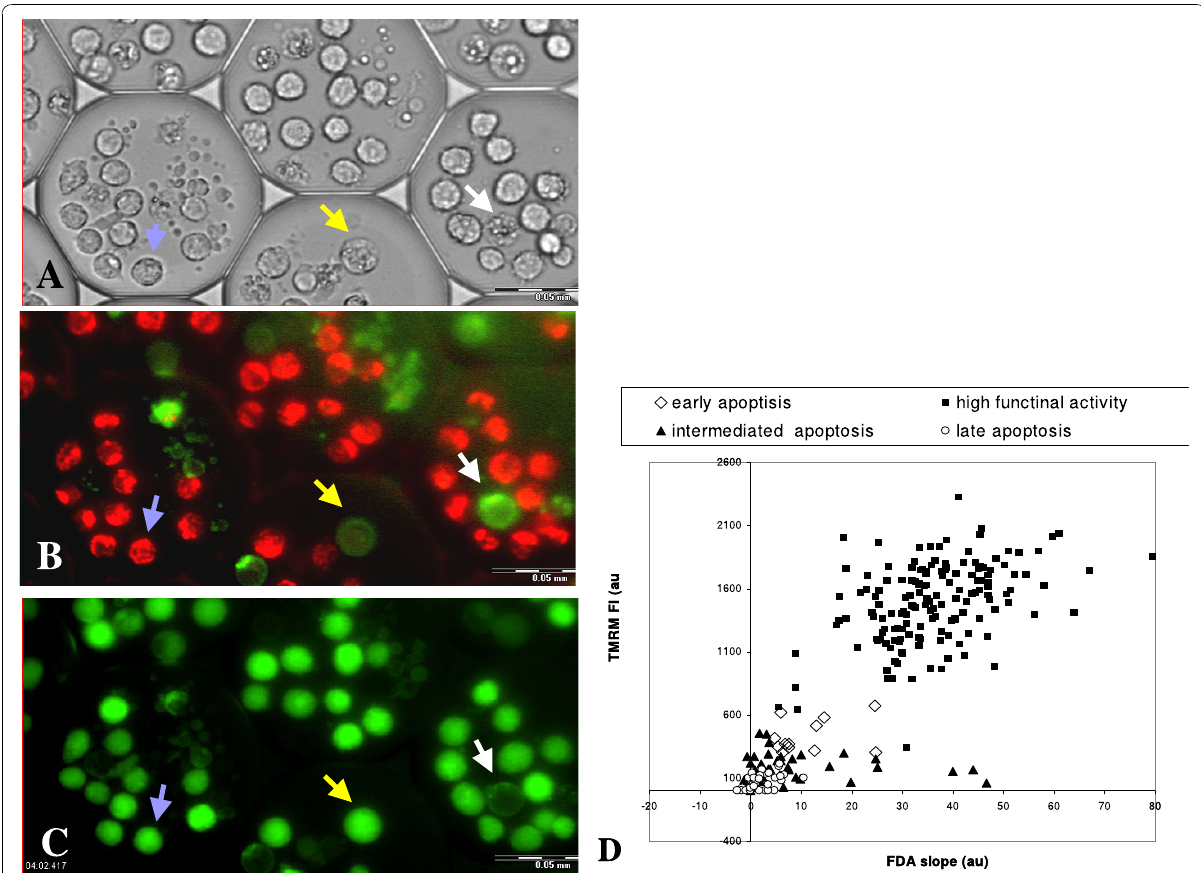
Figure 8 Multi-parametric staining of cryopreserved U937 cells . U937 cells were loaded into 100 μ m i3C and underwent a freezing - thawing cycle. After 24 hours of post-thawing culture, the U937 cells were stained sequentially first by TMRM and Annexin V and next by FDA and PI. Transmitted light (A) and fluorescent images of U937 cells stained with TMRM and Annexin V (B), and FDA (C) are presented. Arrows indicate different cell statuses: Blue - high functional activity - morphologically intact, highly TMRM and FDA positive, Annexin V negative; Yellow - early apoptosis - a morphologically changed cell with a slightly condensed nucleus, exhibiting low TMRM staining, FDA positive staining and strong Annexin V staining; White - late apoptosis - a morphologically changed cell with nucleus defragmentation and pronounced Annexin V positive staining, TMRM and FDA negative staining. Scale bar: 0.05 mm. (D) Scatter diagram of individual TMRM (FI) values vs. esterase enzymatic activity values (slopes), measured in post-thawed U937 cells 24 hours after cell thawing. Note the detection of 4 cell subgroups based on their functional activity